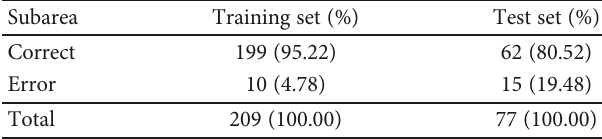
Table 4: Classi fi cation accuracy of training set and test set ( n (%)).